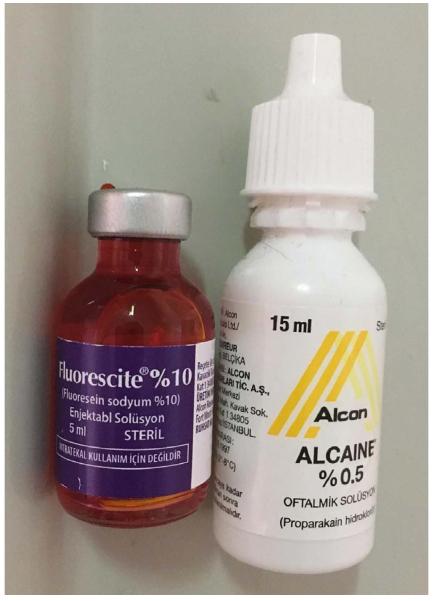
Figure 1: Proparacaine 0.375%-sodium fluorescein 0.25% eye drop mixture.